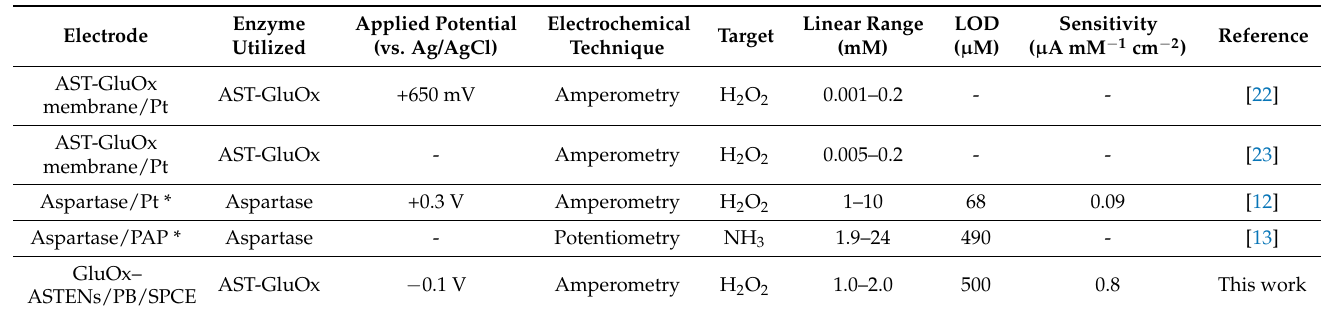
Table 2. Comparison of the parameters obtained from various amperometric and potentiometric Asp biosensors.